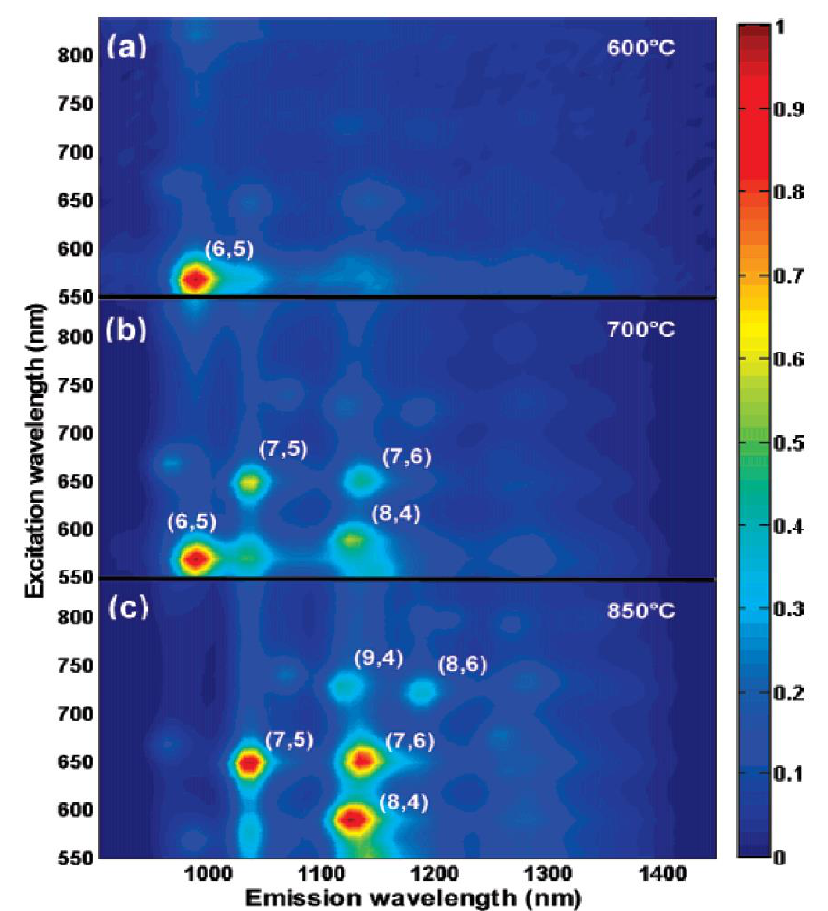
Figure 7. The photoluminescence maps of SWCNTs synthesized at ( a ) 600, ( b ) 700, and ( c ) 800 °C. The chirality indices are labeled near every pronounced peak [58]. Copyright 2007, American Chemical Society.